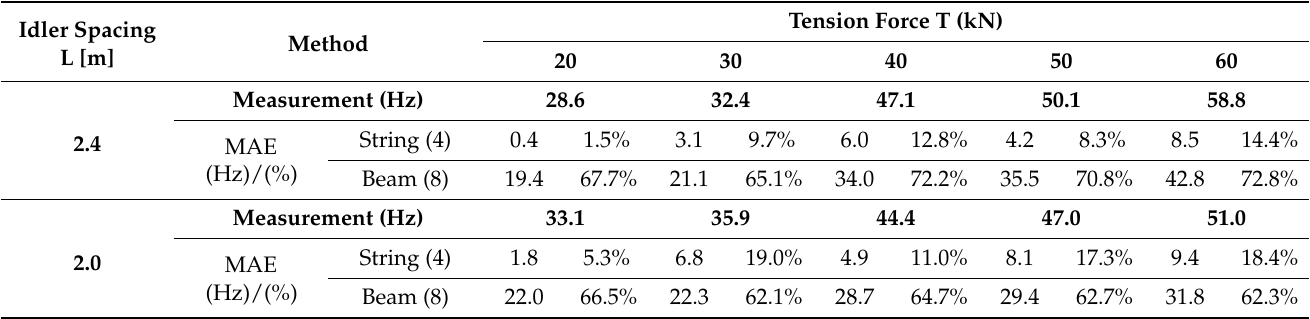
Table 2. Differences between the theoretical models and the mean measurement results for the belt speed of 2.4 m/s. Idler Spacing L